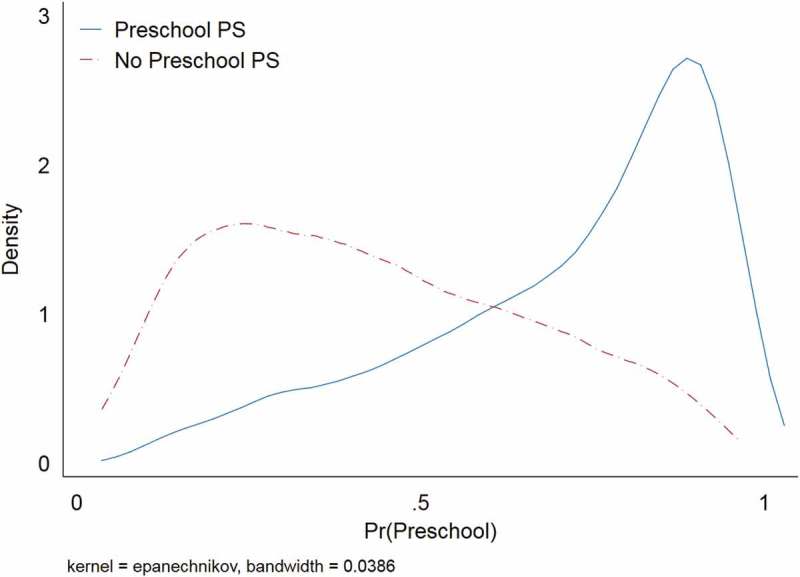
Propensity score for preschool attendance.
Notes: This graph shows shows the distribution of propensity scores for preschool attendance and no preschool attendance based on a logit model using education of the mother, education of the father, age, age squared, second generation migrant, and regional dummies. Source: Authors’ calculations on EU-SILC 2011.